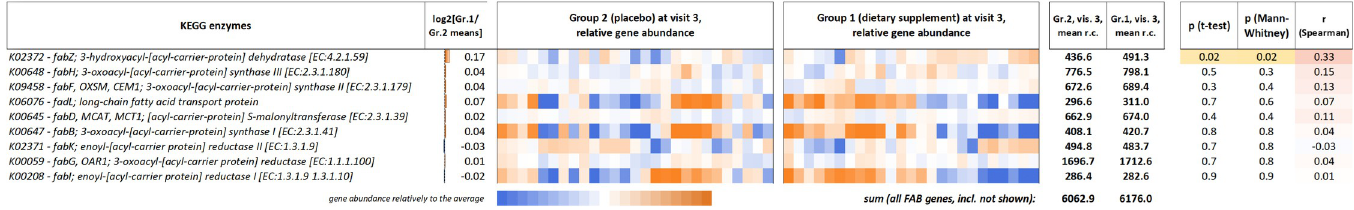
Fig 6. The relative content in the metagenome of genes participating in FAB in patients of groups 1 and 2 at visit 3 (inferred from taxonomic data). Columns 5 and 6 show the average content of FAB genes in each group. The heatmaps in columns 3 and 4 demonstrate the relative gene abundance per sample. The samples are re- arranged according to the similarity of gene abundance